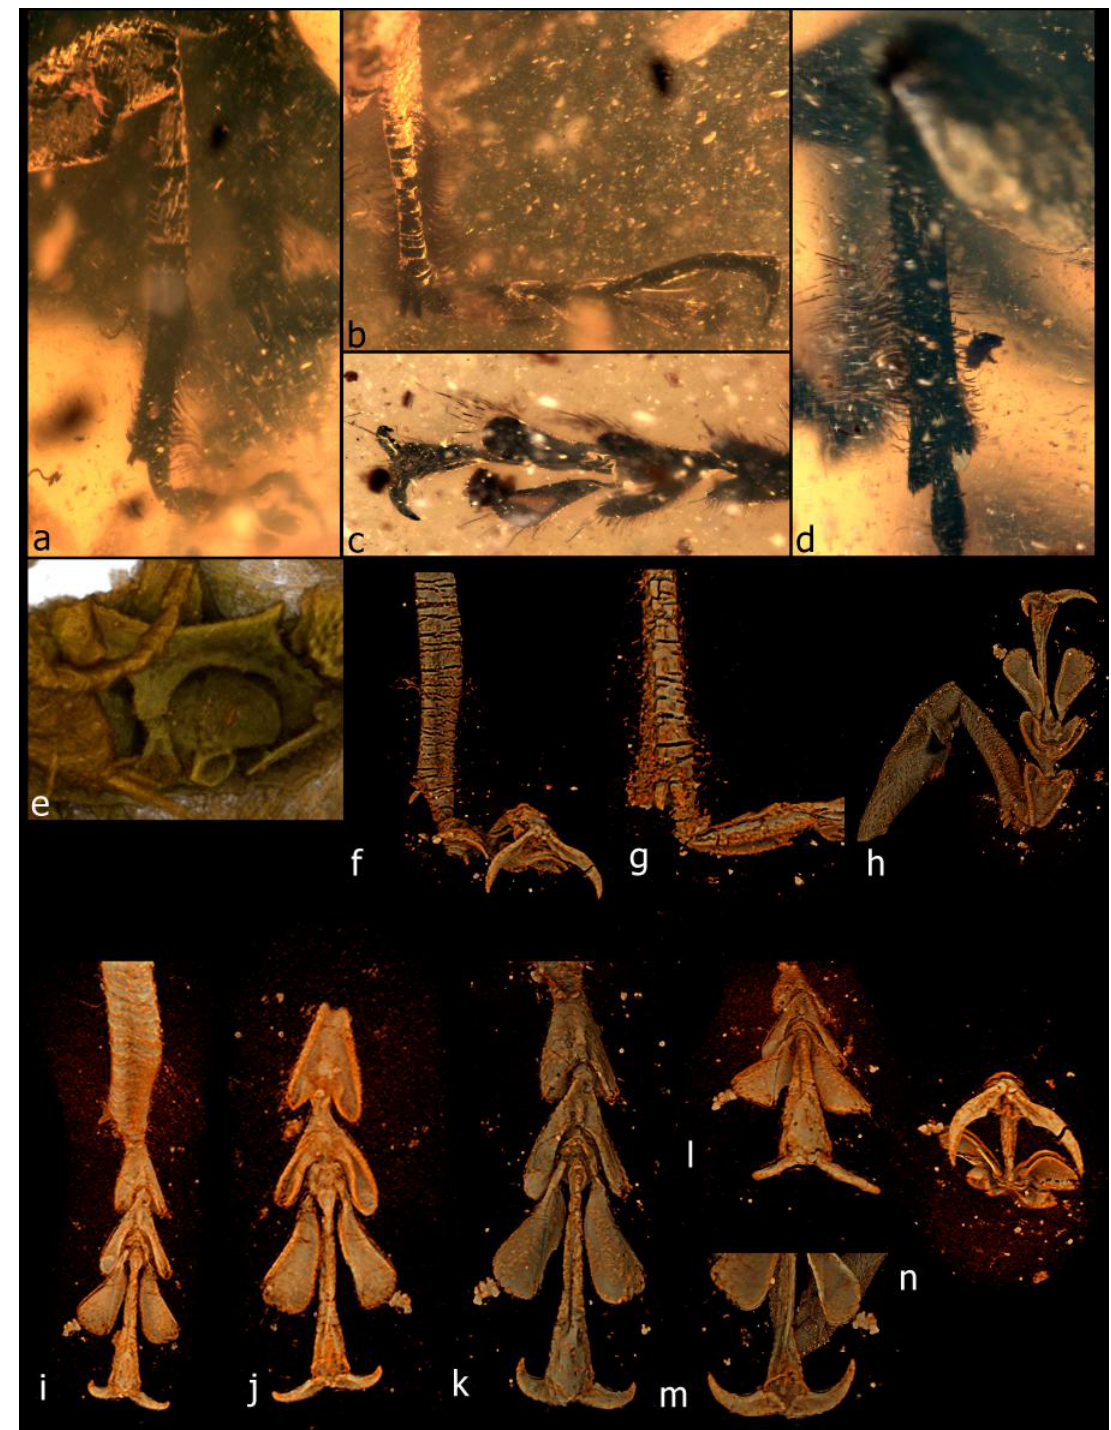
Figure 30. Cetionyx batiatus sp. n., holotype. Mesotibia showing spurs ( a ); mesotibia and -tarsus ( b ); protarsus ( c ); metatibia showing spurs ( d ); details of prothorax, ventral ( e ); micro-CT scan reconstructions showing details of tibiae and tarsi ( f–n ). See also Video S2.